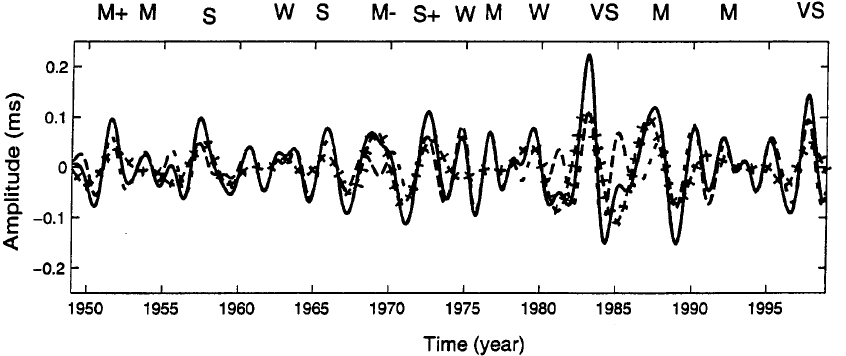
Fig. 15. Interannual variations in AAM (i.e. TAAM ): interannual, 1.5 to 5 years bold line ; quasi-biennial band, 1.5 to 2.9 years dashed line ; triennial-quadrennial band (3 to 5 years) dashed line plus